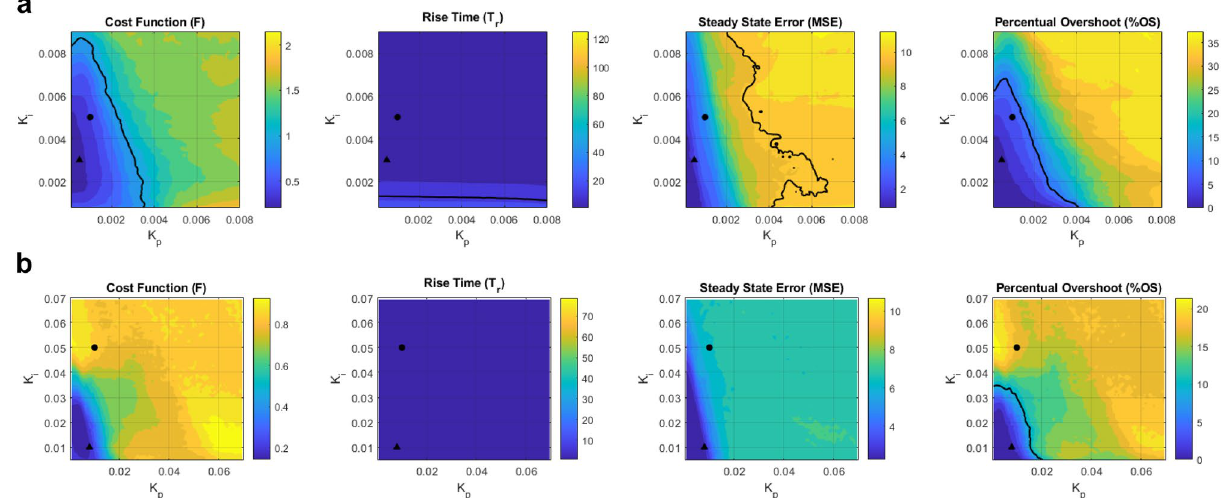
Figure 3. Contour plots of average performance indicators for the whole virtual study population in parameter space (K p , K i ) for ( a ) continuous stimulation and ( b ) cardiac-synchronized stimulation. Initial gain combinations found based on single individual simulation are depicted as point marker and optimized gain combination selected on virtual population are depicted as triangle marker. The acceptable limits for all performance indicators are highlighted by the black contour lines. In the panels where no black contour line is visible, the entire parameters space is part of the optimal